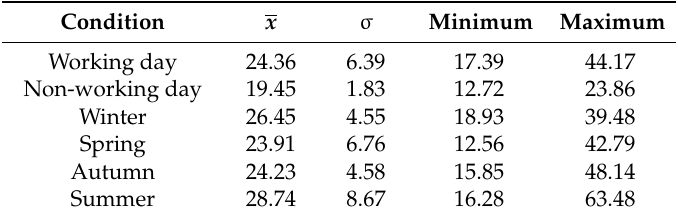
Table 1. Statistical analysis of the power demand profiles (in kW).